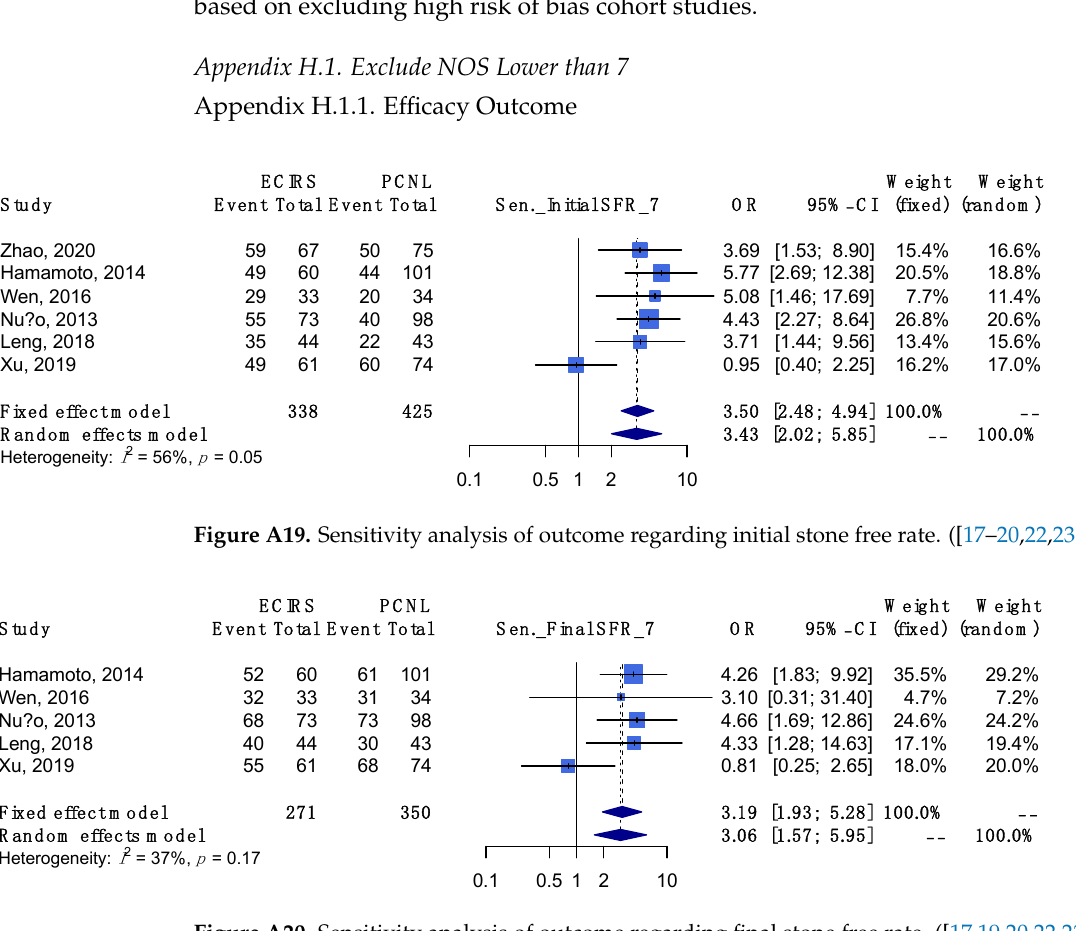
Figure A21. Sensitivity analysis of outcome regarding overall complications. ([17–20,22,23])